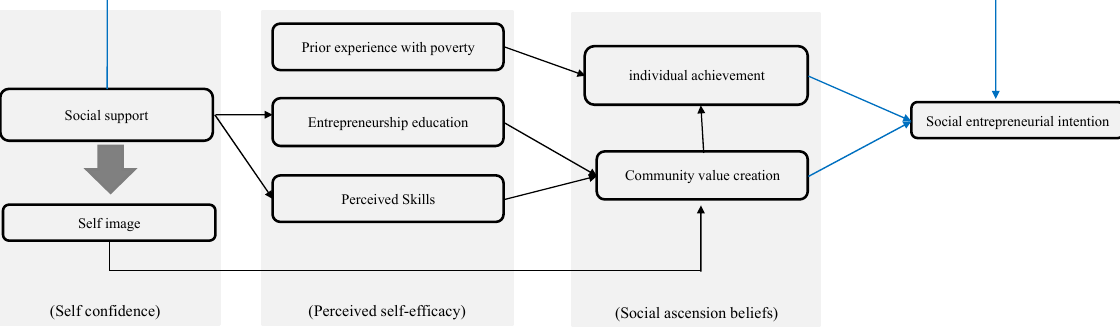
Figure 3. grounded model of SEI at BoP. Figure 3. Grounded model of SEI at